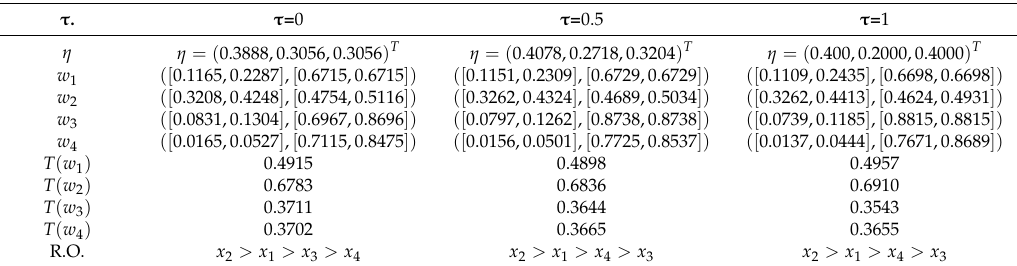
𝛕. Table 3. Computation results for different DMs’ weights η i ( i = 1,2,3 ) by Wan’s method [12].